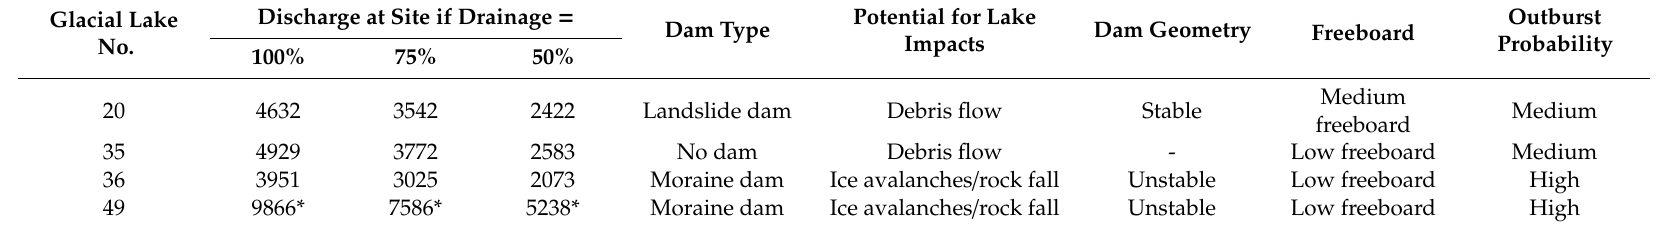
Table 4. Maximum discharge and physical features of the critical